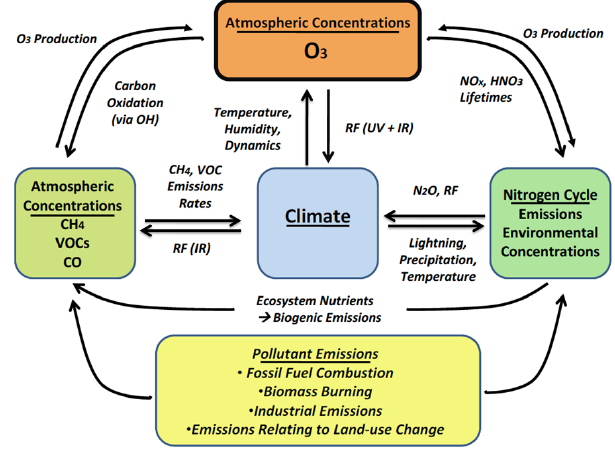
Figure 1. Schematic representation of the interactions of ozone in the Earth system (EPA,